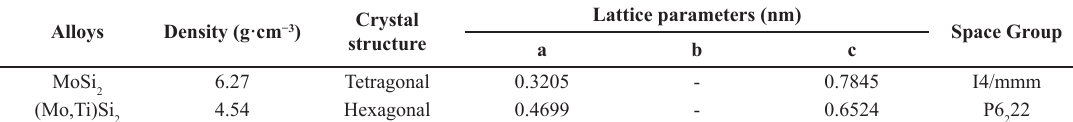
and (Mo,Ti)Si2. 2